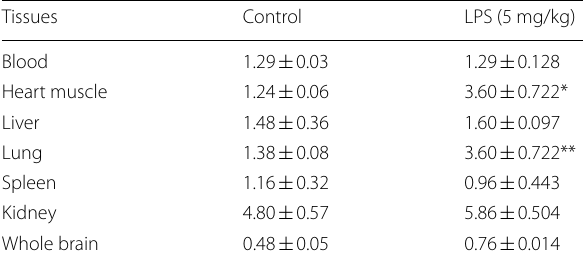
Table 1 Biodistribution of accumulated radioactivity (SUV) in various tissues at the designed time points after